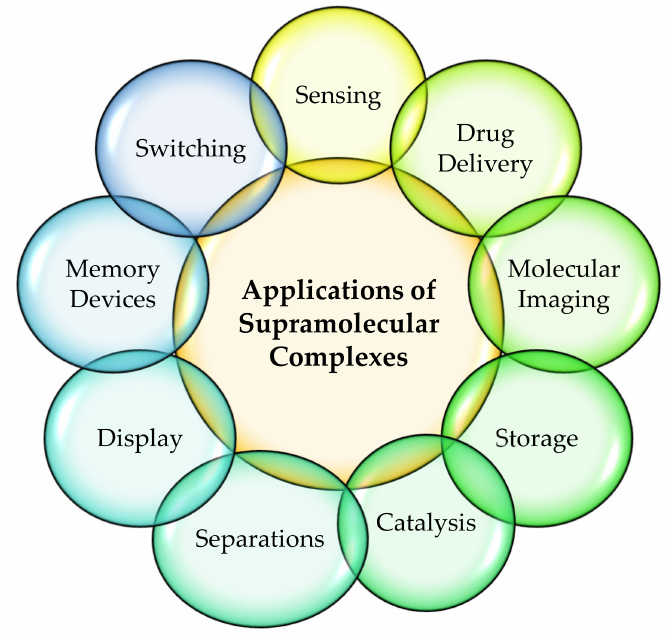
Figure 1. Applications of supramolecular complexes in host-guest